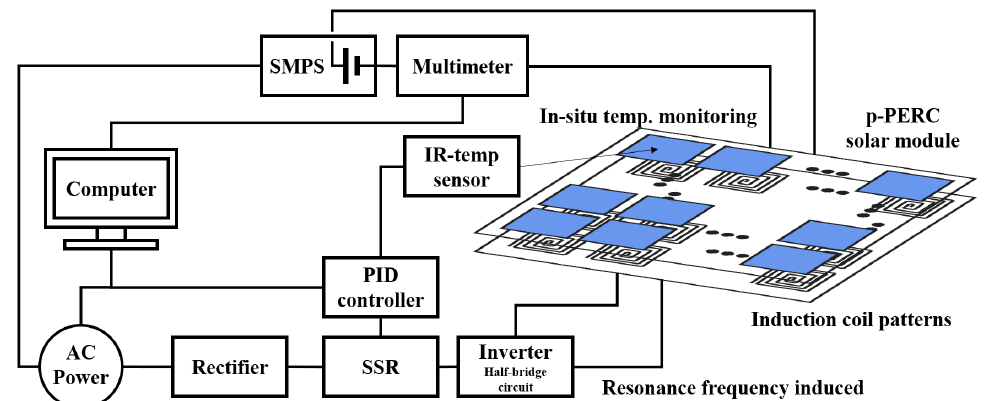
Figure 1. Schematic diagram of remote heating apparatus for a p-PERC solar module for the treatment of